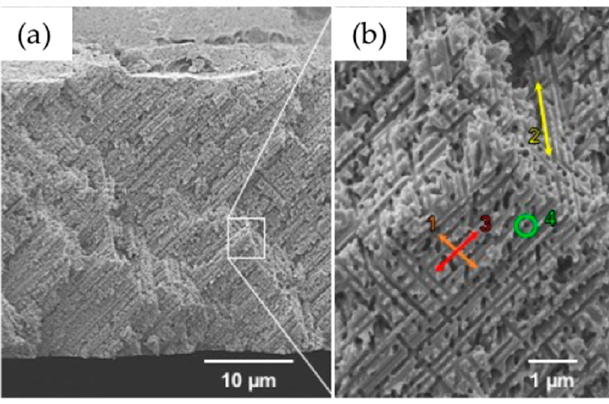
Figure 2. Scanning electron microscopy (SEM) images of ( a ) the cross-section of a representative template with high aspect ratio cylindrical interconnected channels, and ( b ) zoom-in indicating the four directions of the interconnected pores.